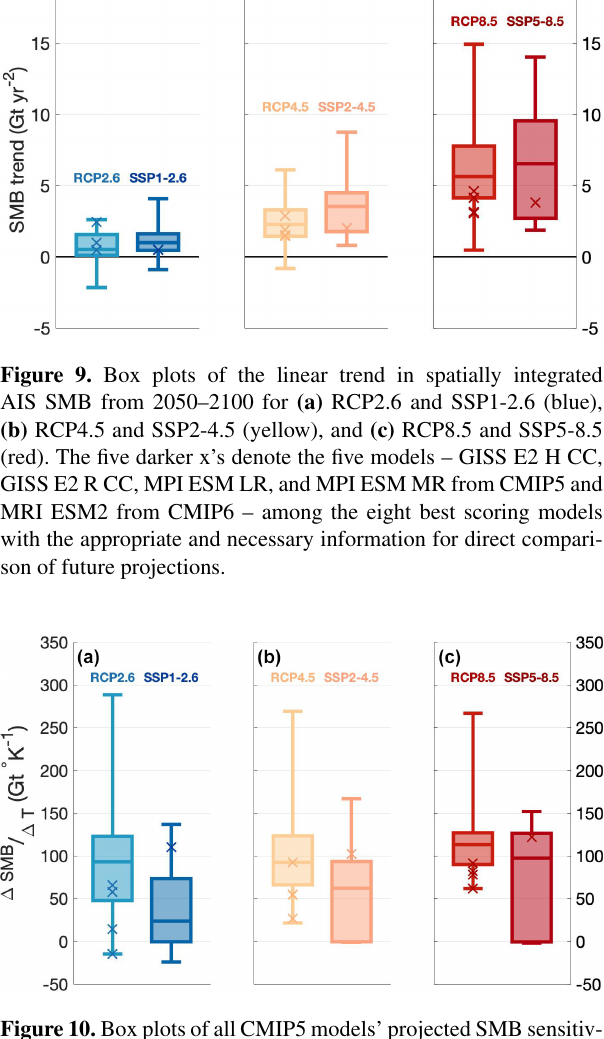
Figure 10. Box plots of all CMIP5 models’ projected SMB sensitiv- ity to temperature changes ( (cid:49) SMB/ (cid:49)T ) for (a) RCP2.6 and SSP1- 2.6, (b) RCP4.5 and SSP2-4.5, and (c) RCP8.5 and SSP5-8.5. The five darker x’s denote the five models – GISS E2 H CC, GISS E2 R CC, MPI ESM LR, and MPI ESM MR from CMIP5 and MRI ESM2 from CMIP6 – among the eight best scoring models with the appropriate and necessary information for direct comparison of future